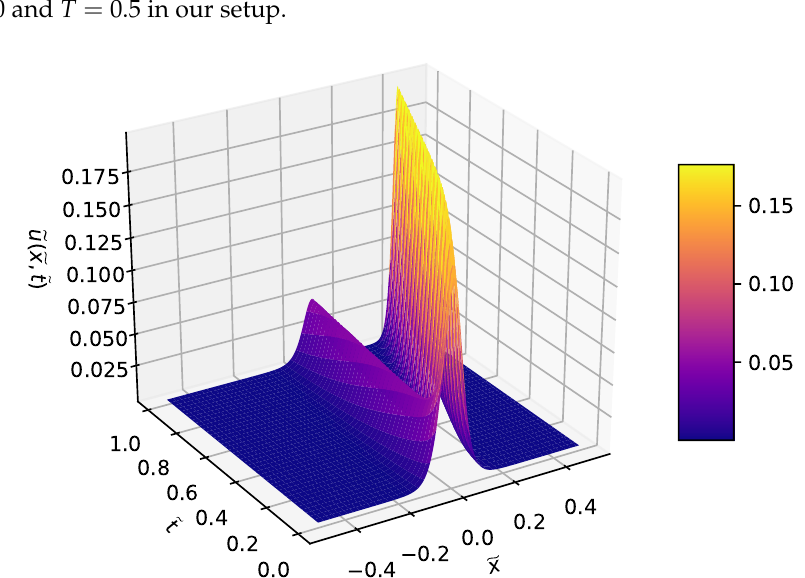
Figure 8. Non-dimensional analytical solution of KdV